Question: Write the caption for this figure.
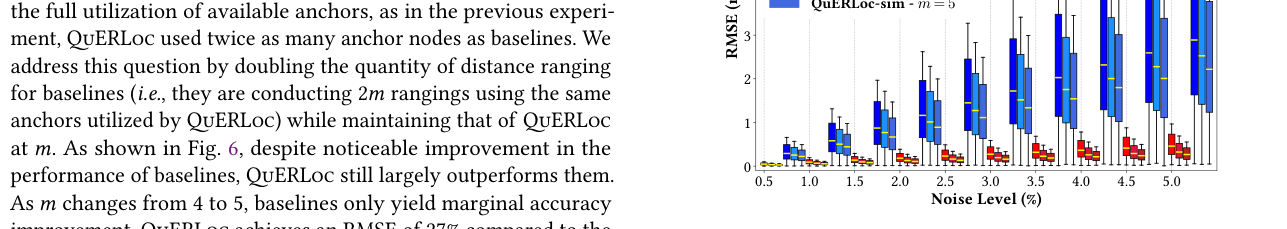
Answer: Comparison of QuERLoc and QuERLoc-sim with 𝑚= 3, 4, 5 under non-zero noise levels 0.5% to 5%. Each cluster of boxes corresponds to one noise level.